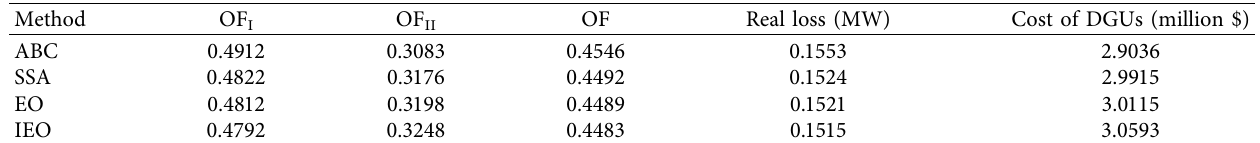
Table 8: Te comparison of the objective function values for the IEEE 85-bus system.